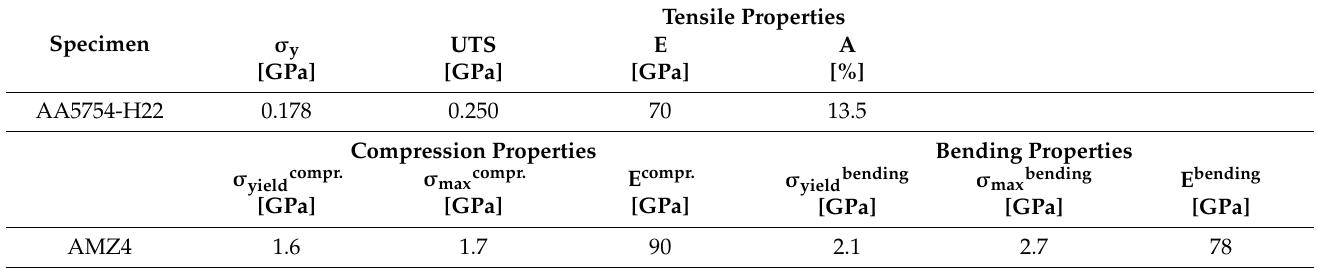
Table 1. The results of monotonic tensile tests of AA5754-H22 according to the DIN EN ISO 6892-1 process A: yield strength ( σ y ), ultimate tensile strength (UTS), Young’s modulus (E) and ultimate elongation at fracture point (A). In addition, the results of the compression and 3-point bending test of AMZ4: yield strength ( σ yield ), maximum strength ( σ max ) and compression or bending modulus (E) for both cases. Tensile